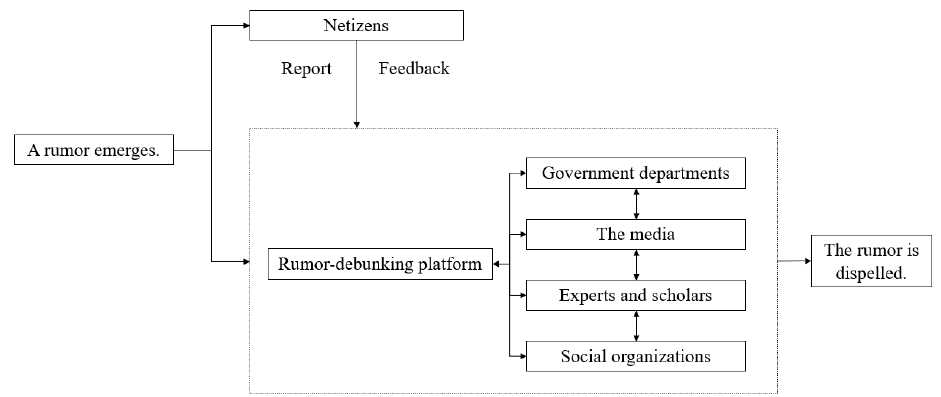
Figure 5. The “ multi-agent collaborati ve” rumor -debunking